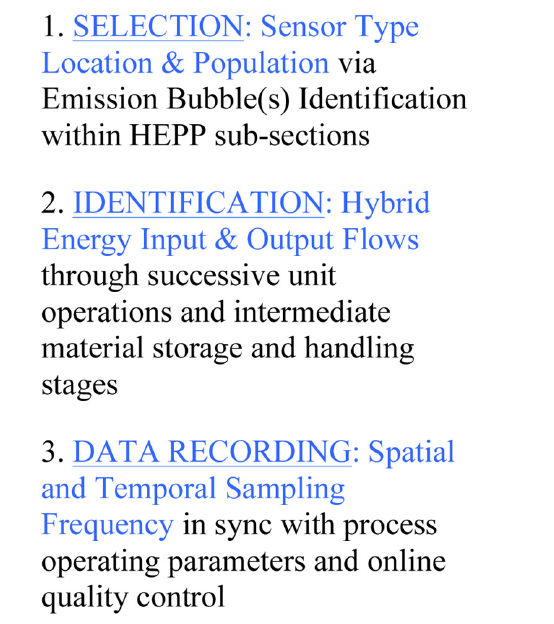
FIGURE 2 | Environmental sensing platform required for multiple detection and